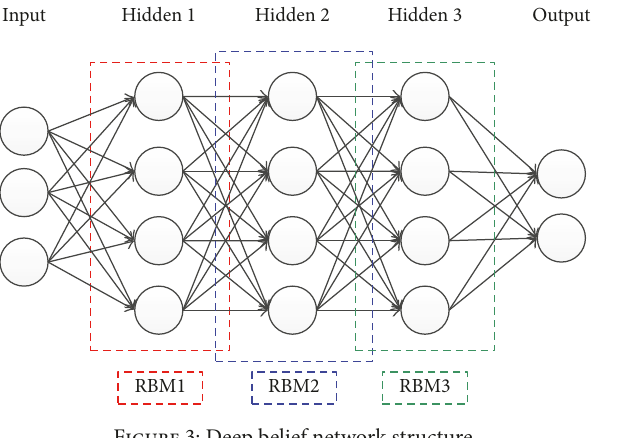
Figure 3: Deep belief network structure.